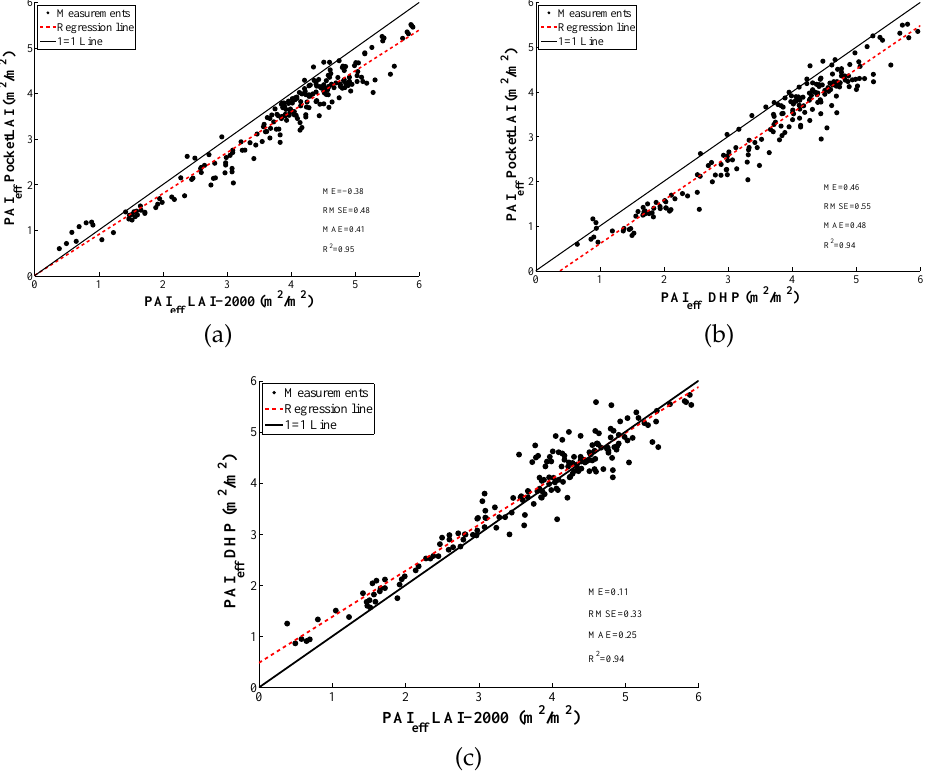
Figure 4. Comparison of effective plant area index measurements collected in the 2014 Spanish ERMES field campaign between: ( a ) PocketLAI and LAI-2000; ( b ) PocketLAI and Digital hemispherical photography (DHP) and ( c ) DHP and